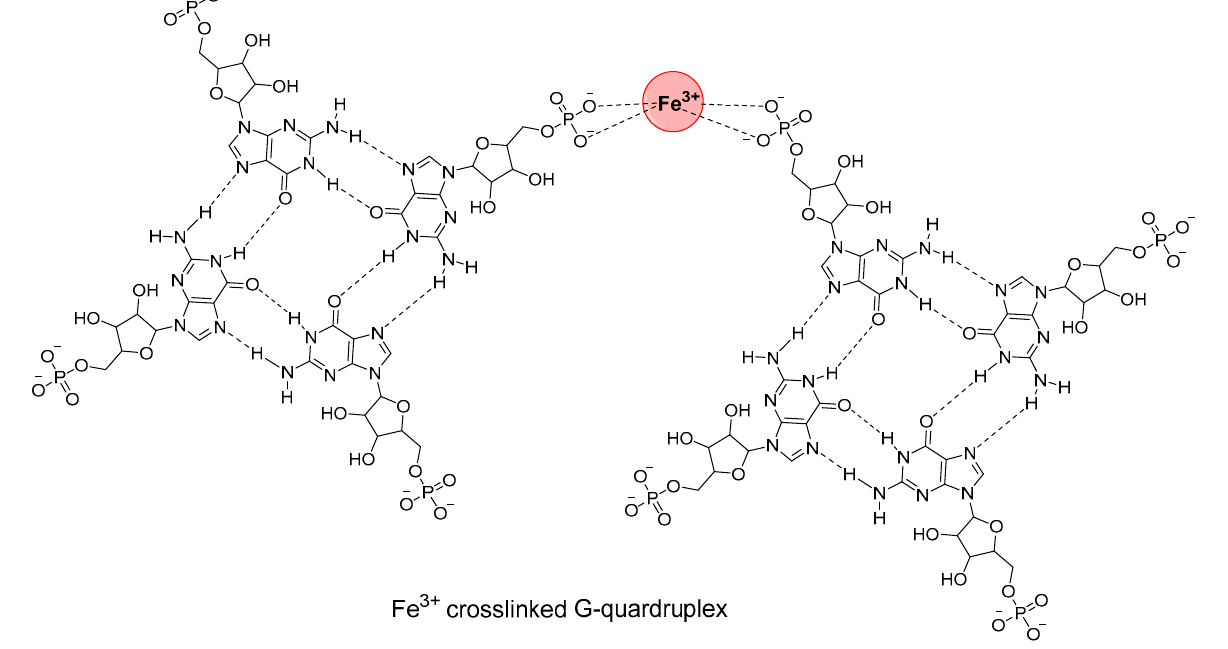
Figure 49. The self-assembled G-quadruplex with Fe 3+ [97].